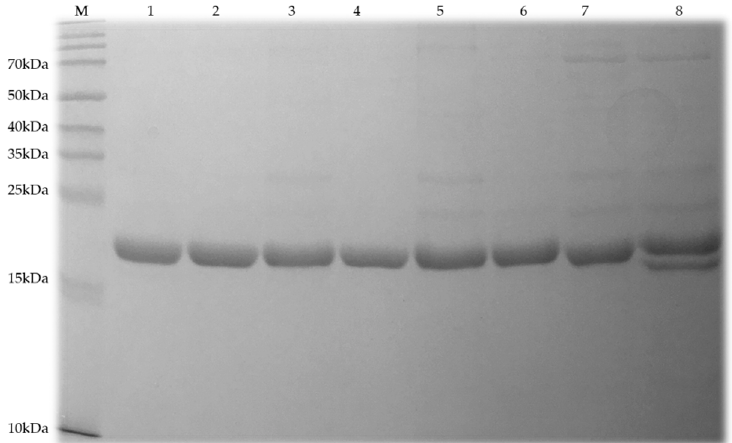
Figure 3. SDS-PAGE analysis of WT PlyC CHAP and its mutants. The solubility and purity of each enzyme after the His-tag cleavage were assessed via a 7.5% SDS-PAGE gel. The lanes correlate to: (M) BioRad protein markers; ( 1 ) PlyC CHAP WT; ( 2 ) PlyC CHAP +1; ( 3 ) PlyC CHAP +2; ( 4 ) PlyC CHAP